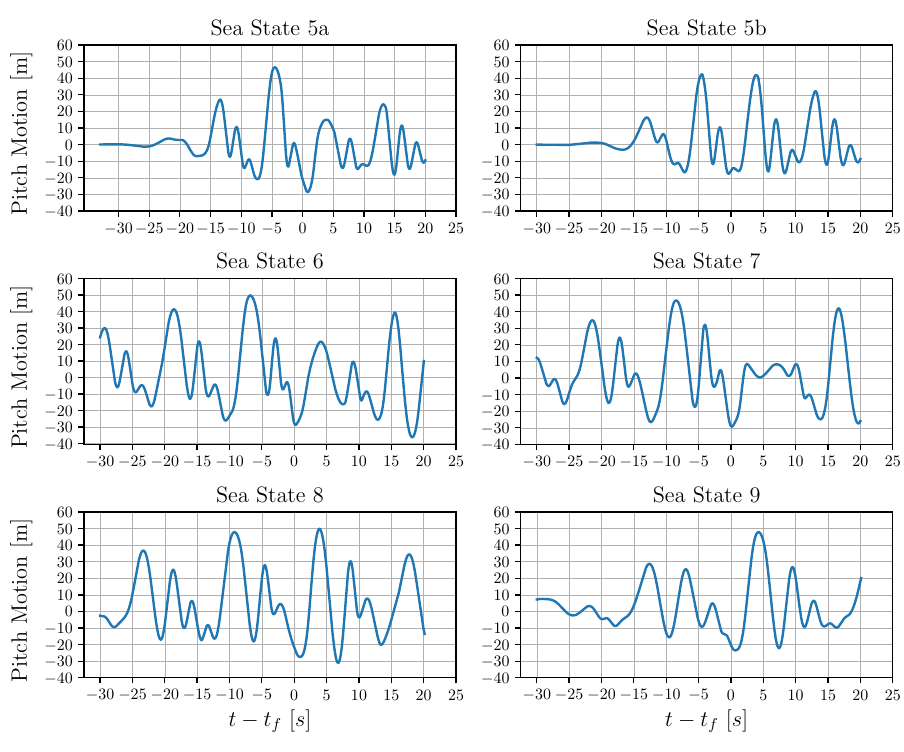
Figure 13. For all the examined sea states, the pitch response time series during the wave–structure interaction is shown.